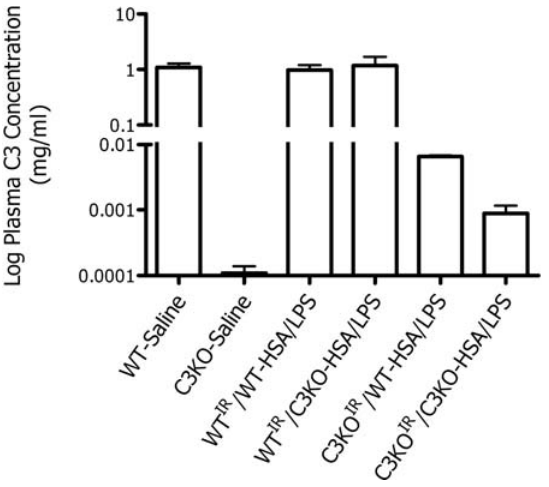
Figure 5. Plasma C3 concentrations as determined by ELISA. Measurements are from terminal plasma samples and demonstrate normal levels of C3 in all WT mice. C3KO animals and C3KO IR /C3KO chimeras had C3 concentrations below 0.001 mg/ml, approaching the lower limit of the assay. However, there was measurable C3 in the plasma of C3KO IR /WT chimeric